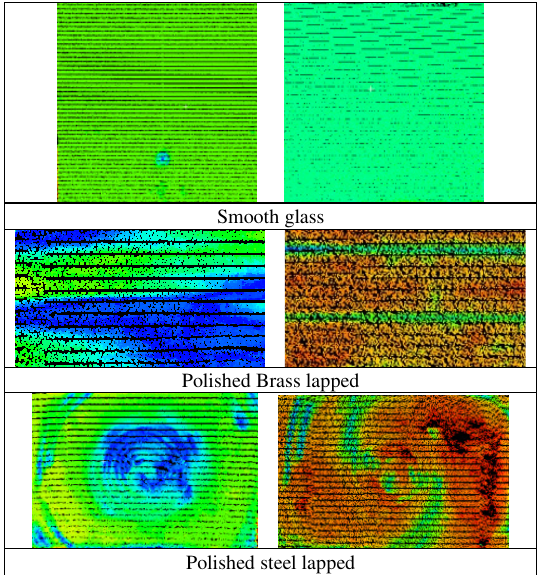
Table 2 – e.g. scanning recovery nadir (left) and left (right) for